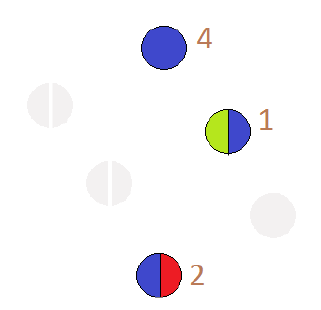
Figure A10. Demonstration of a mouse-hover interaction in force directed layout when a node participates in more than one circle.